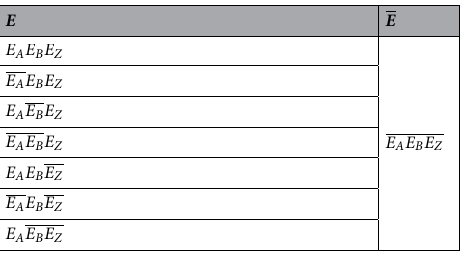
Table 1. Logical structure E A ∨ E B ∨ E Z of E , used as a proxy representing the unobservable mediating mechanism that involve no cross-talks. The left column shows the possible combination of realization of the effect. The right column shows the single possible combination of no realization of the effect.